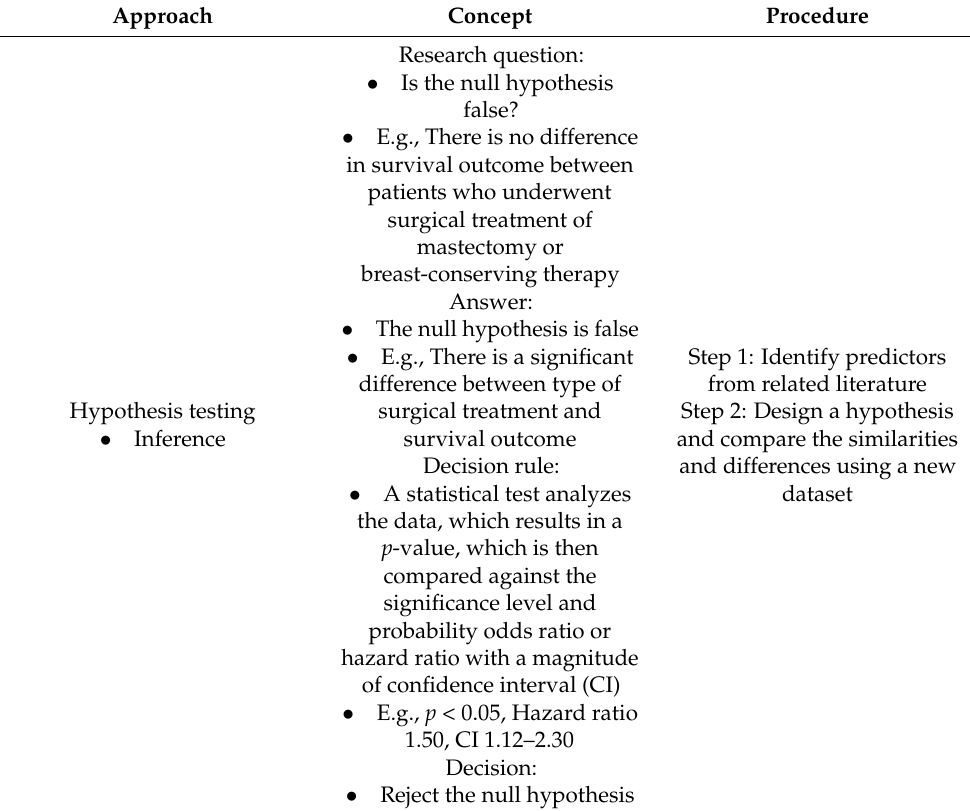
Table 1. Concepts in hypothesis